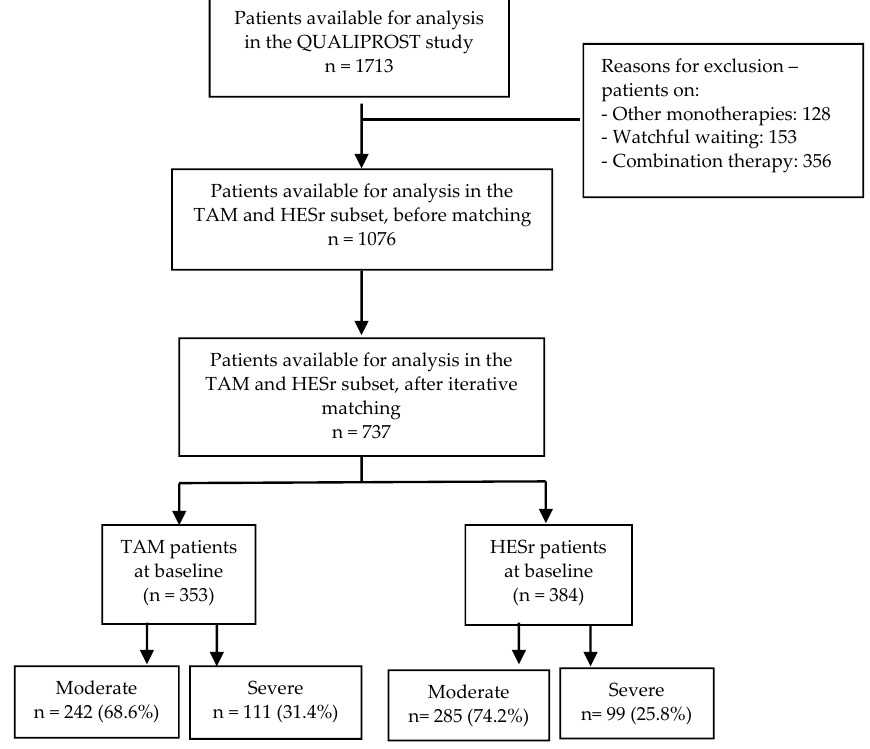
Figure 1. Study flow-chart: iterative matching based on IPSS (total, voiding and storage sub-scores, and item 8) and BII scores, maximum urinary flow rate (Qmax), prostate-specific antigen (PSA), and prostate volume at baseline. TAM: tamsulosin; HESr: hexanic extract of Serenoa repens .